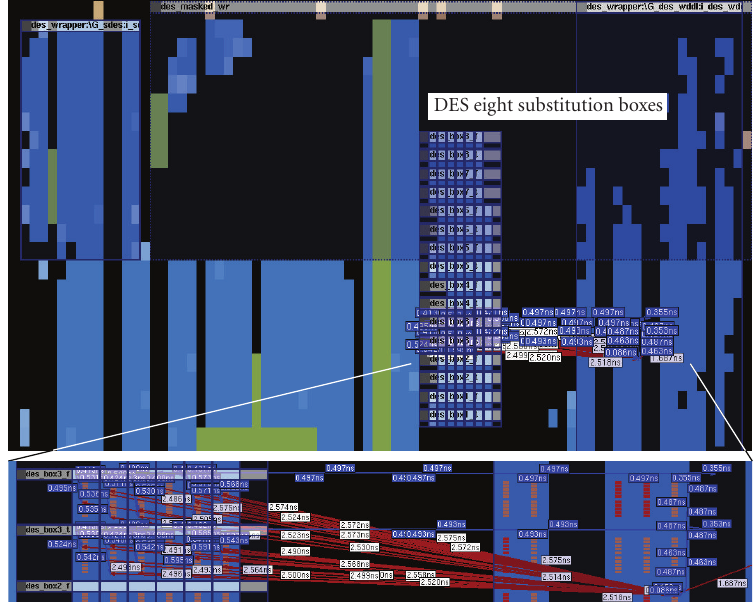
Figure 5: Floorplan of a full DES in WDDL (top) and slightly unbalanced fanout of one register of the “LR” state (bottom).